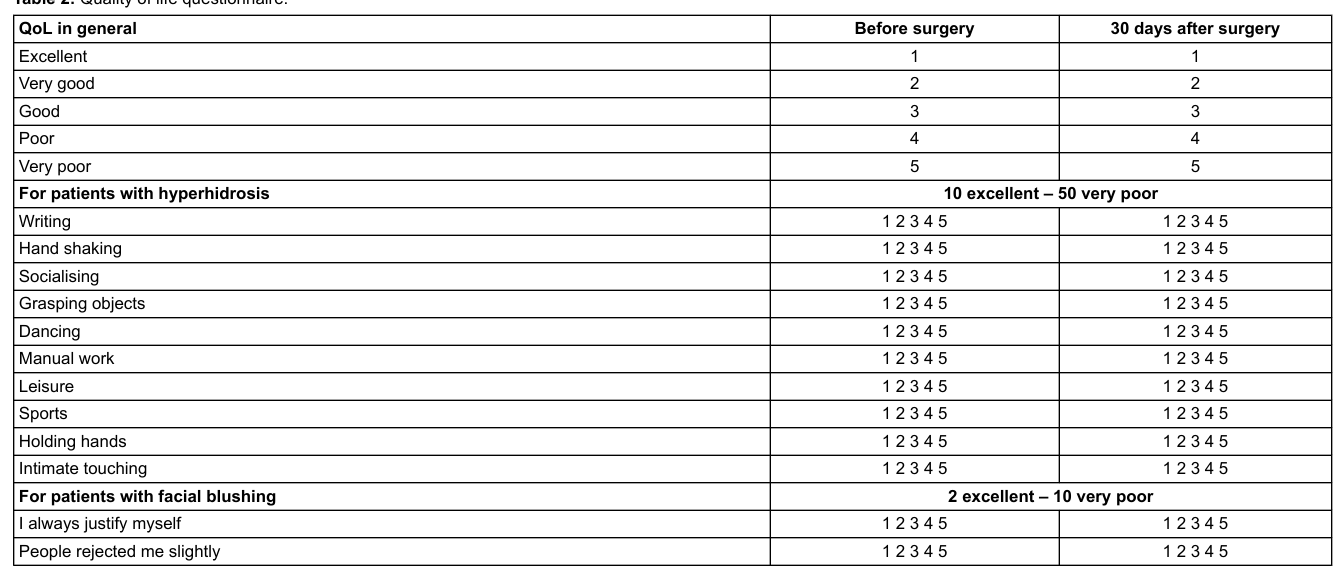
Table 2: Quality of life